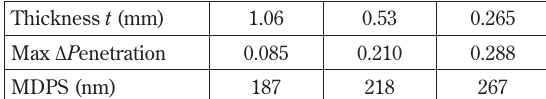
Table 3 The maximum penetration difference be- tween spheres and agglomerates and the cor- responding most differentiating particle size (MDPS) at different filter thicknesses